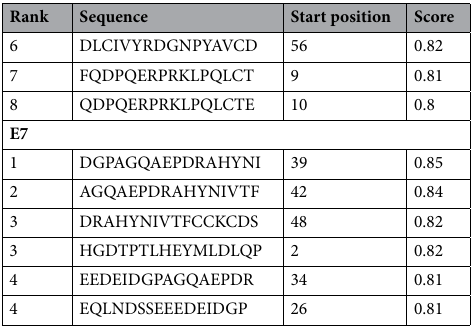
Table 5. B Cell epitopes of L1, E6, & E7 proteins of HPV